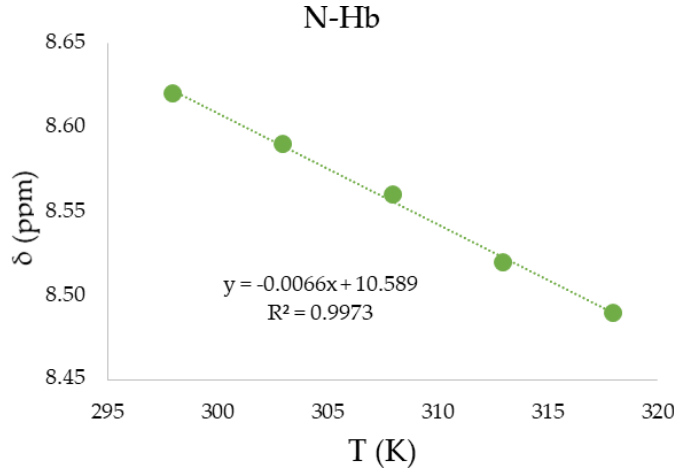
Figure 8. Temperature coefficient calculated for N-Hb of compound 14 (IMID 2).